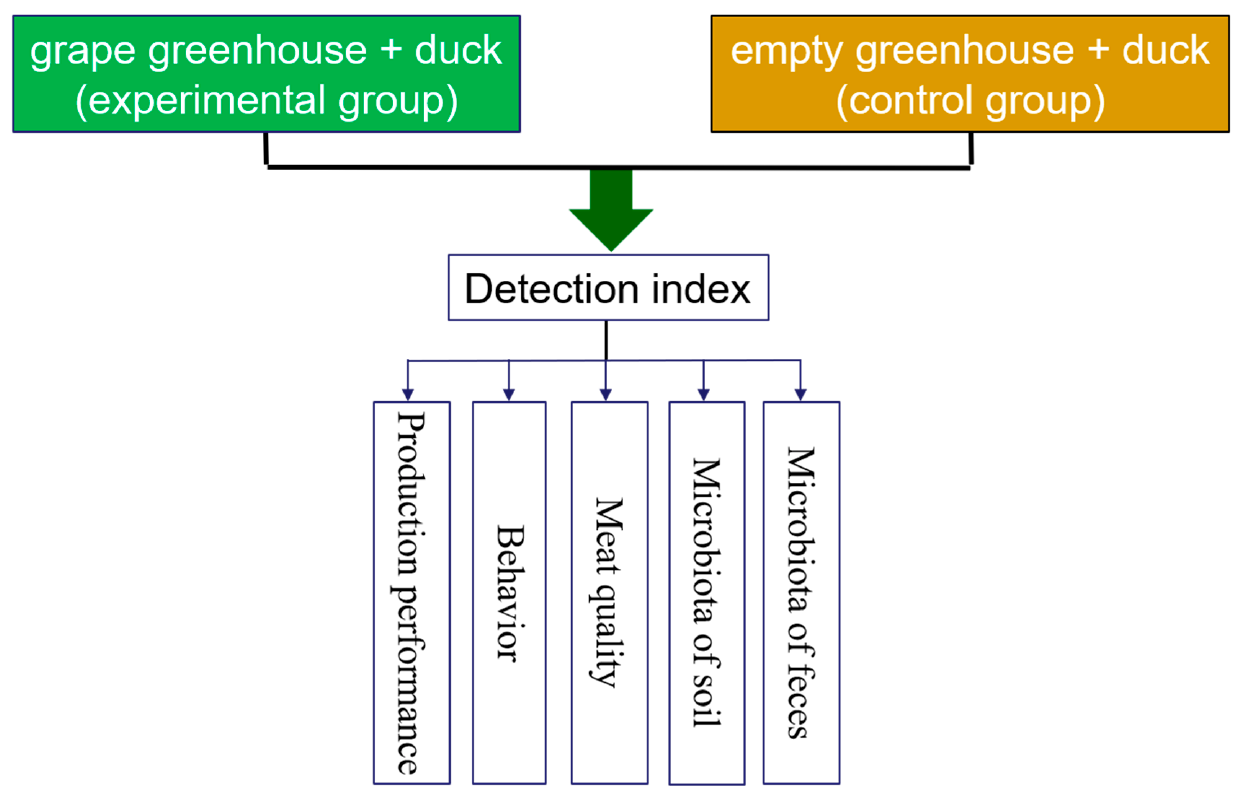
Figure 1. Experimental design blueprint (the experimental group is the integration system of grape-duck, the control group is the conventional farming system of free range). Table 1. Behavior ethogram of